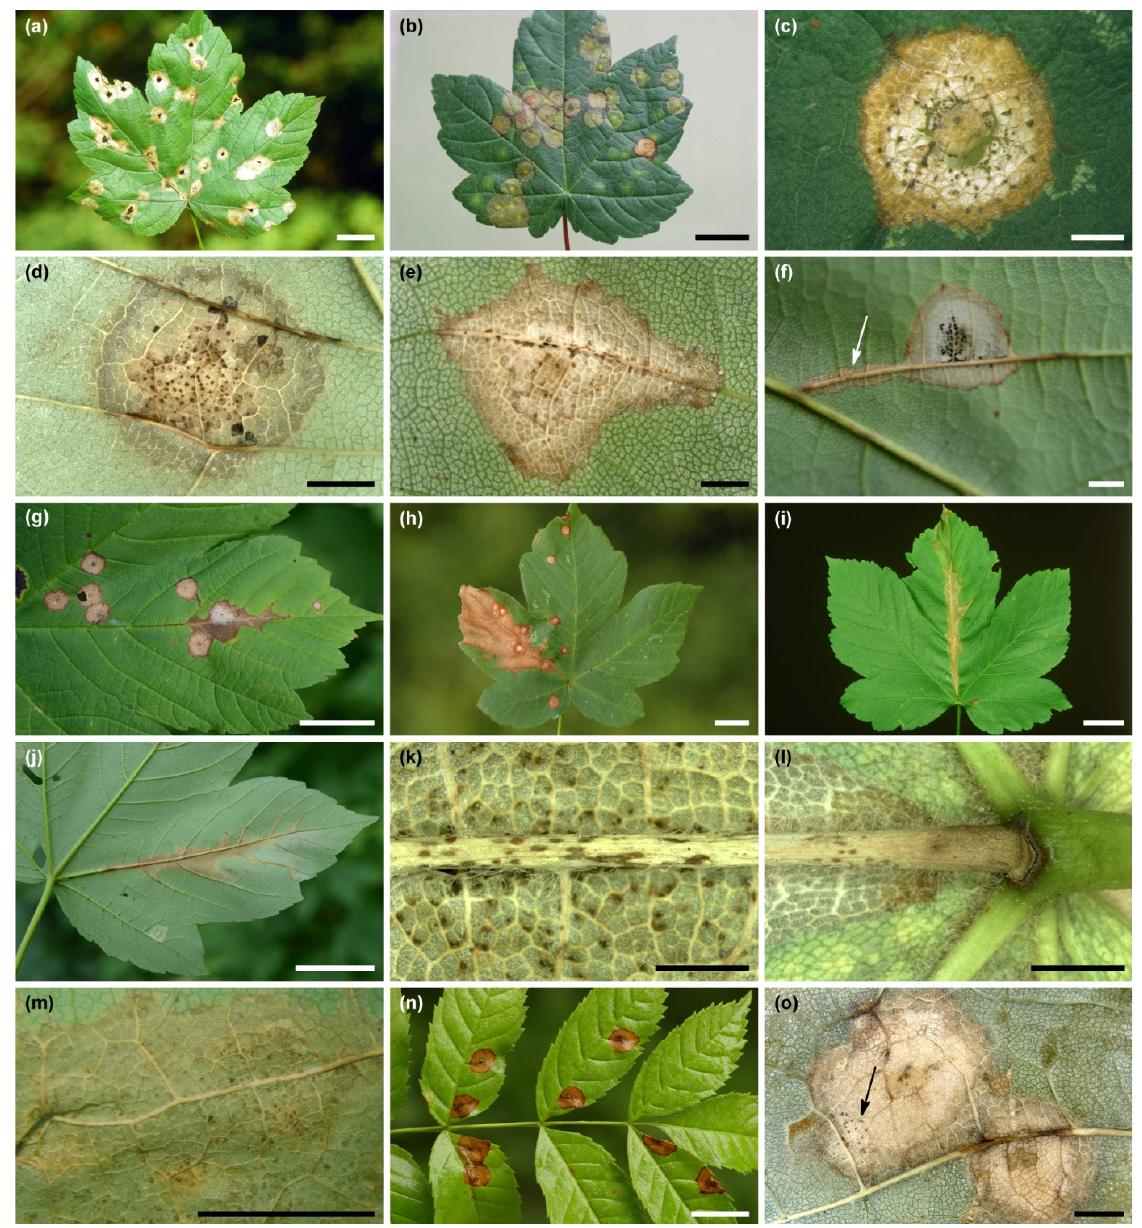
Figure 1. Galls, natural necrotic lesions and conidiomata of Apiognomonia hystrix on living leaves of Acer pseudoplatanus and Fraxinus excelsior . Acer pseudoplatanus ( a – m ): galls and necrotic lesions associated with Dasineura vitrina ( a ) and Drisina glutinosa ( b ); conidiomata of A. hystrix associated with Da. vitrina , upper side ( d ) and Dr. glutinosa , lower side of the leaf ( d , e ); anthracnose associated with Da. vitrina ( f ) and Dr. glutinosa ( g ); galls of Dr. glutinosa surrounded by necrotic leaf section ( h ); anthracnose on leaves associated with A. hystrix , no insect-related damage ( i , j ); conidiomata of A. hystrix on necrotic part of the leaf ( k – m ); Fraxinus excelsior ( n , o ): necrotic lesions associated with Dasineura fraxinea ( n ); conidiomata of A. hystrix on lower side of the leaf associated with galls of Da. fraxinea ( o ); scale bars: ( a , b ) = 20 mm, ( c – f ) = 2 mm, ( g – j ) = 20 mm, ( k , l ) = 2 mm, ( m , n ) = 20 mm, ( o ) = 2 mm.